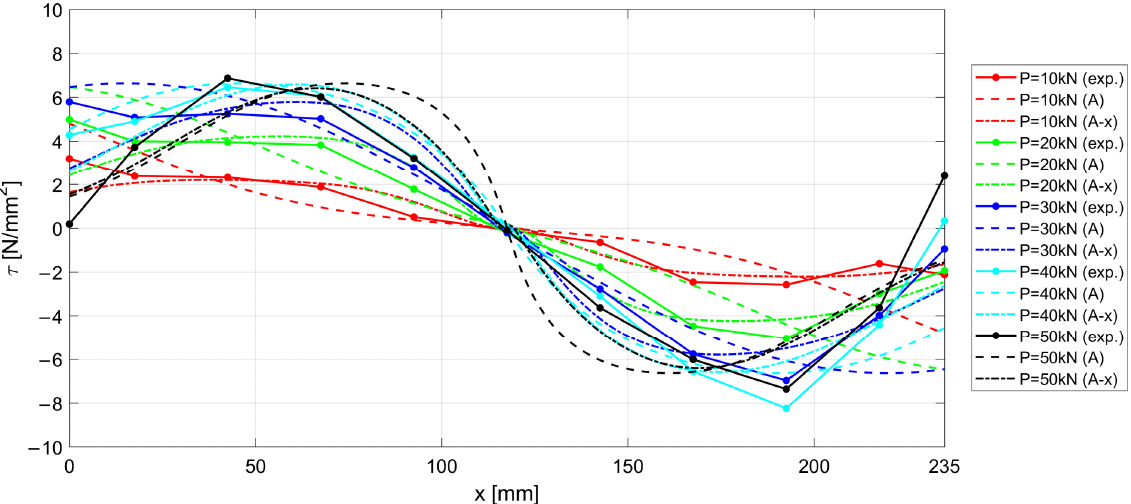
Figure 23. Experimental and numerical τ − x curves for increasing load P . Two numerical formula- tions are presented, obtained by considering a fixed bond–slip model (A) and a model varying the abscissa (A-x).